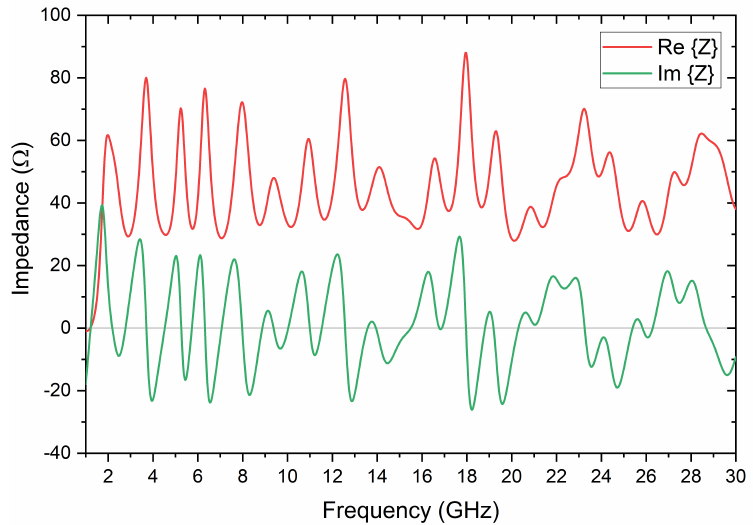
Figure 6. Simulated impedance of the proposed antenna. The results show a very narrow range of variation of the real part of the impedance of only 28–87 Ω , which is very useful for wideband energy harvesting